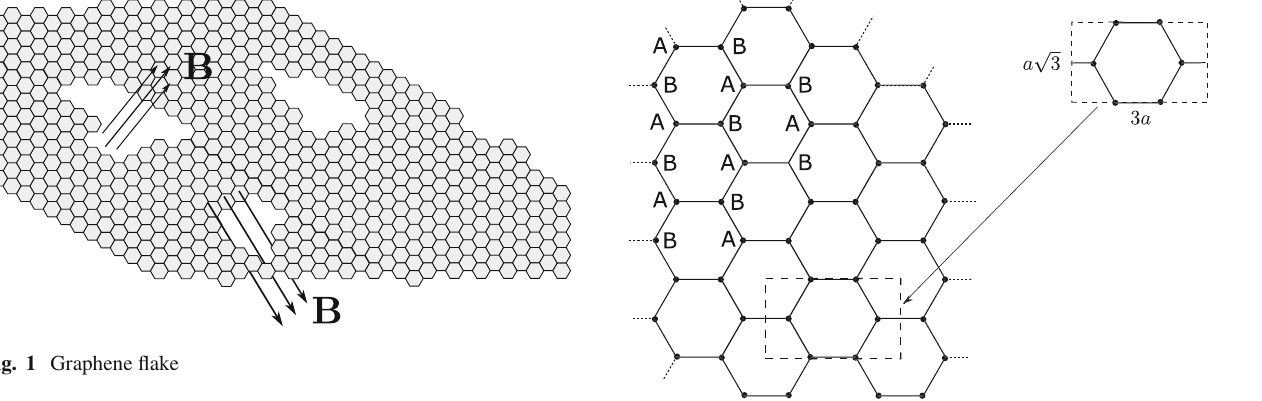
Fig. 2 Graphene honeycomb lattice and one of the hexagons